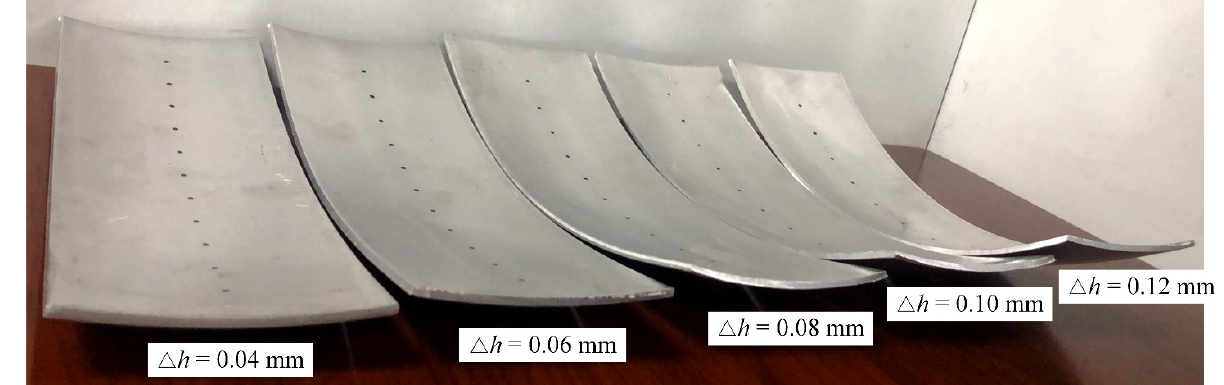
Figure 12. The formed spherical parts with different rolling reductions.